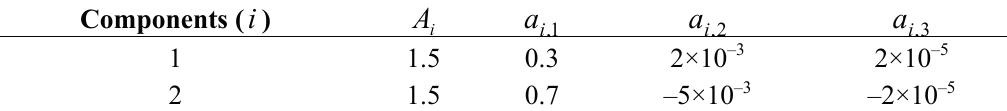
Table 3. Parameters of the two-component cubic phase signal.